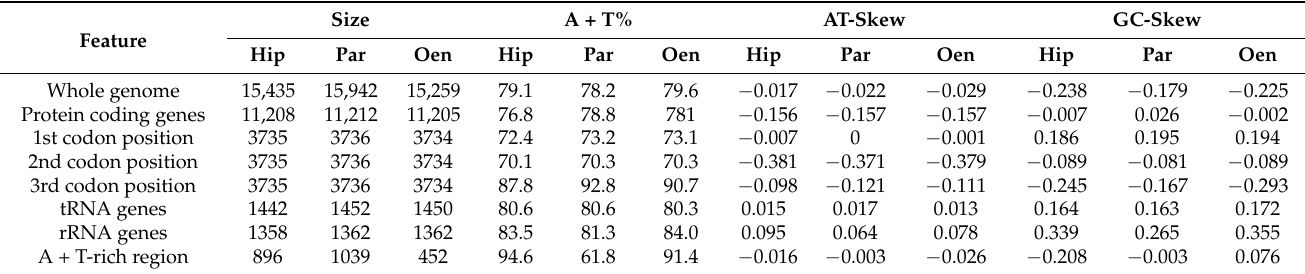
Table 1. Nucleotide composition of Hipparchia autonoe (Hip), Paroeneis palaearctica (Par), and Oeneis buddha (Oen).